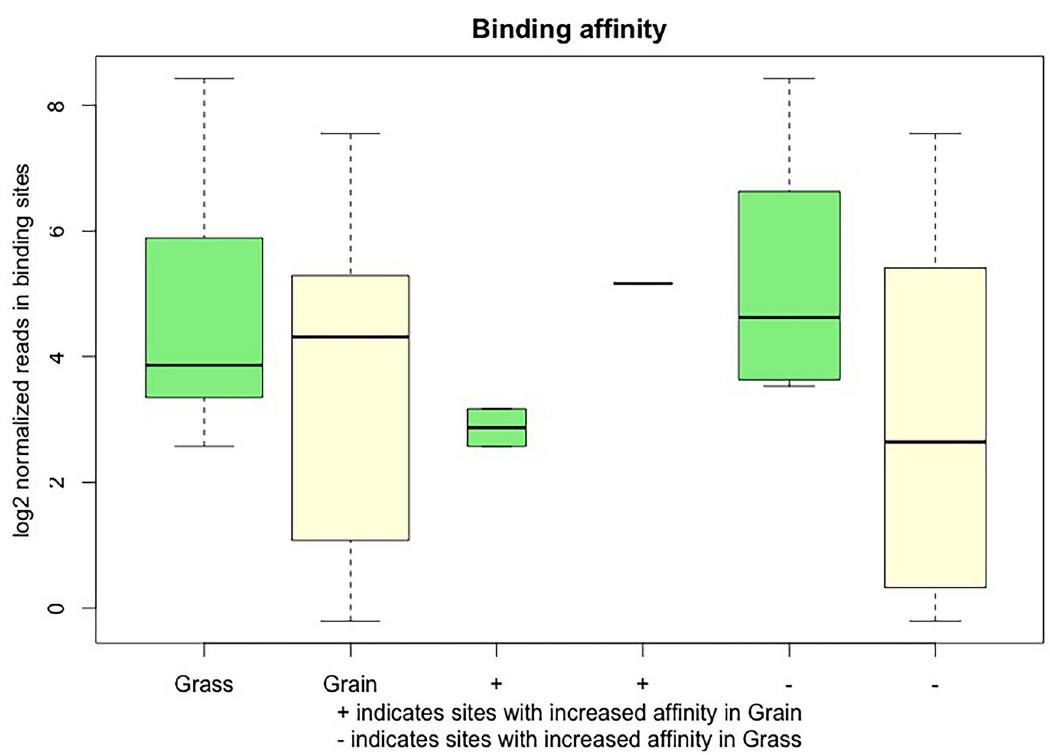
Fig 5. Normalized reads at the binding sites per condition. The first two boxplots represent the overall methylation level in the grass-fed and grain-fed groups. The + sign marked the sites with increased binding affinity in grass-fed group, the - sign represented the regions that enhanced the binding ability in the grain-fed group. The light green and yellow boxes corresponded to grass-fed and grain-fed with + and -,